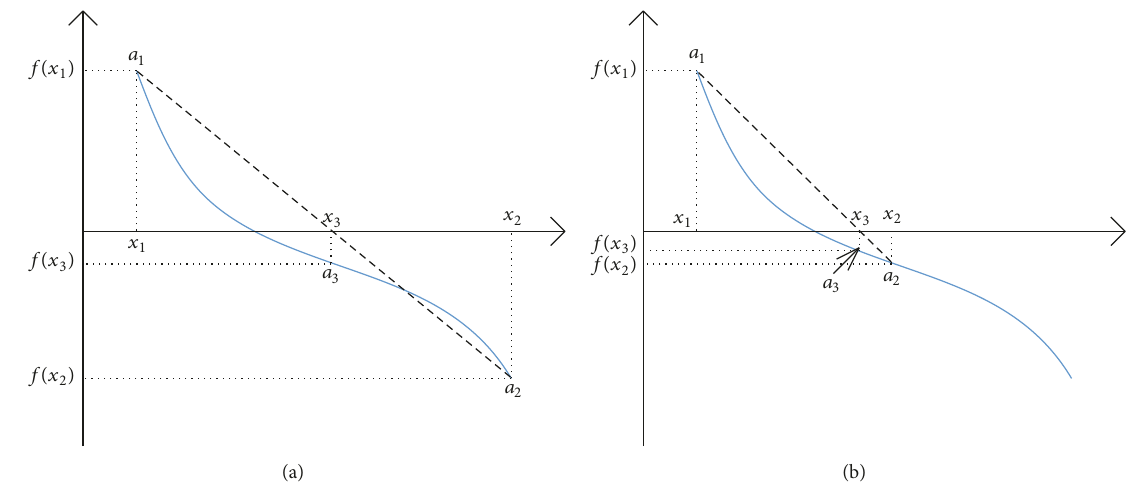
Figure 2: Interpolation procedure used for computing the earliest start